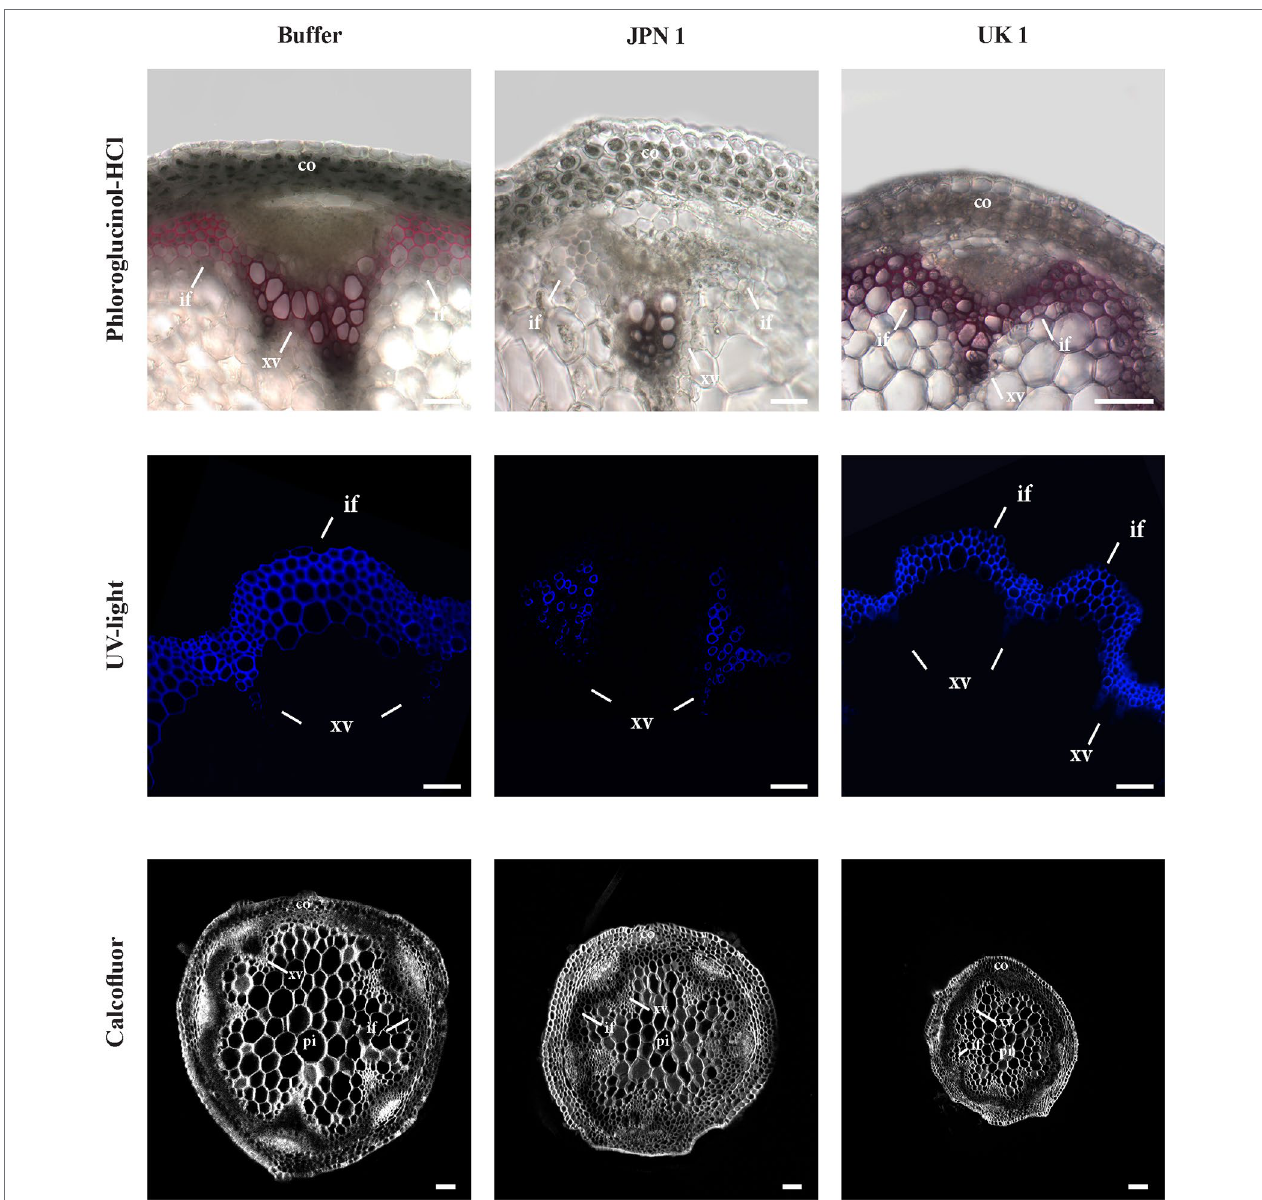
FIGURE 2 | Lignin histochemical analyses of the secondary cell walls (SCWs) of the inflorescence stems from plants mock-inoculated (buffer) or inoculated with either TuMV strain (JPN 1 or UK (1). Top row shows lignin staining with phloroglucinol; middle row shows lignin intrinsic fluorescence upon ultraviolet excitation (UV light); and bottom row shows cellulose staining with Calcofluor. Bars indicate 100 μ m. The cortex (co), xylem vessels (xv), and interfascicular fibers (if) are marked with letters. Note the lack of differentiation in the interfascicular fibers of JPN